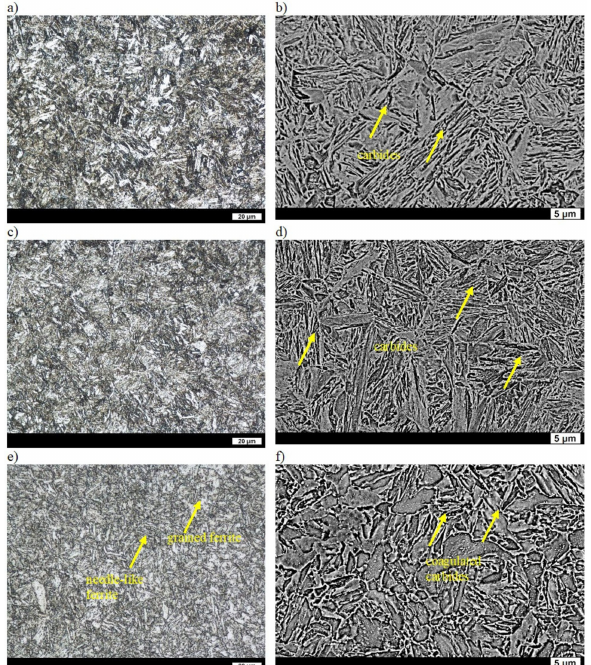
Figure 4. Microstructure of ingot No. 2 after quenching and tempering: ( a ) at 200 ◦ C, LM; ( b ) at 200 ◦ C, SEM; ( c ) at 400 ◦ C, LM; ( d ) at 400 ◦ C, SEM; ( e ) at 600 ◦ C, LM; ( f ) at 600 ◦ C, SEM. Etched with 3% HNO 3